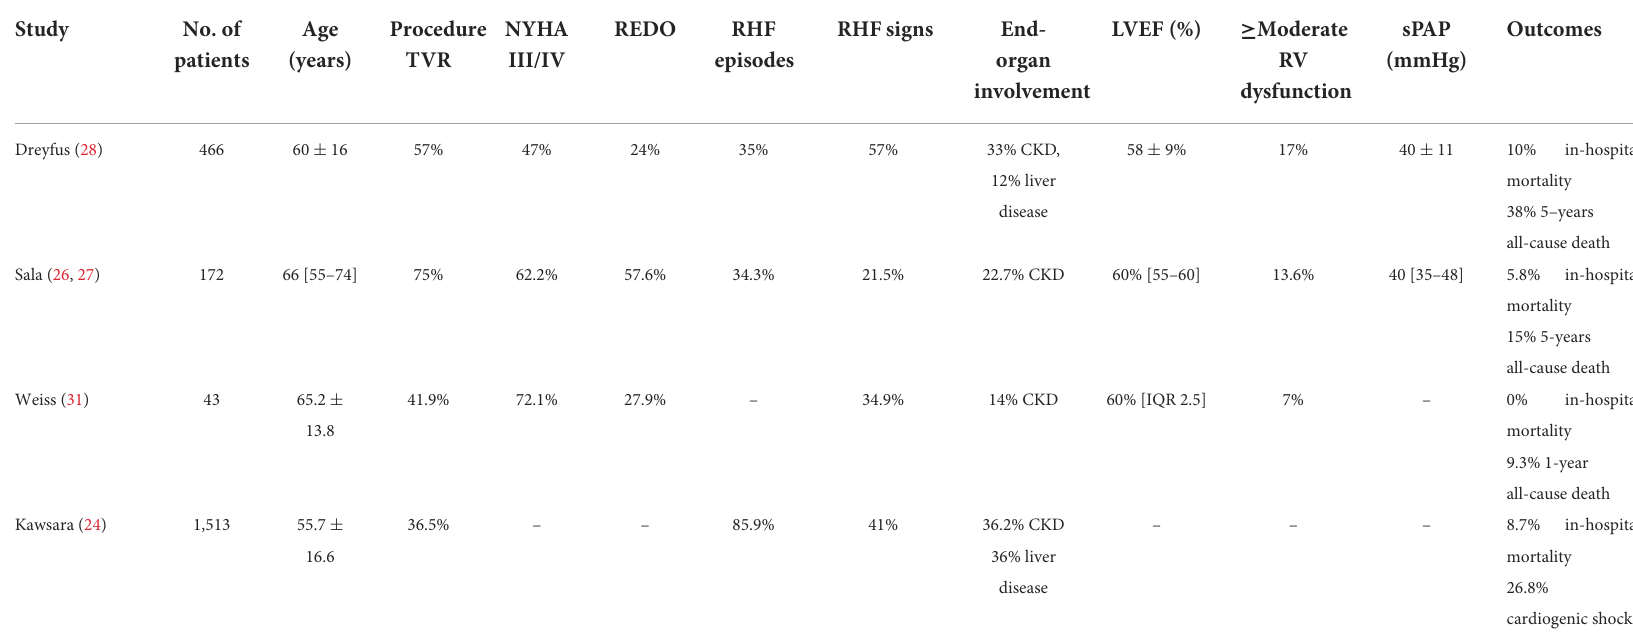
TABLE 1 Characteristics of the surgical studies in the